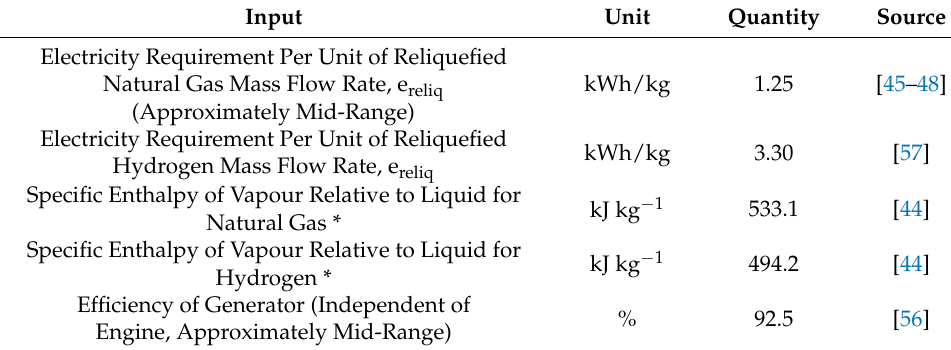
Table 7. Input data for fuel utilisation calculation for reliquefaction [44–48,56,57]. Input